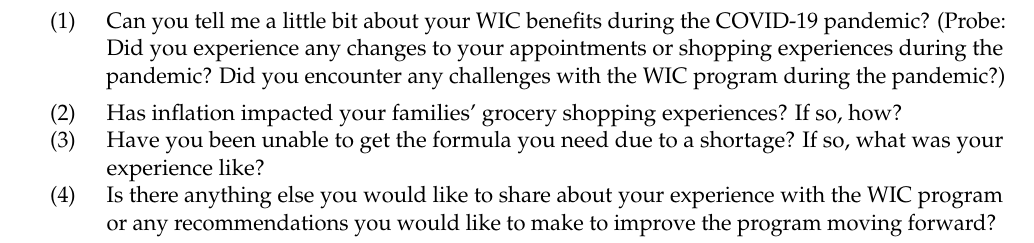
Table 1. Representative interview